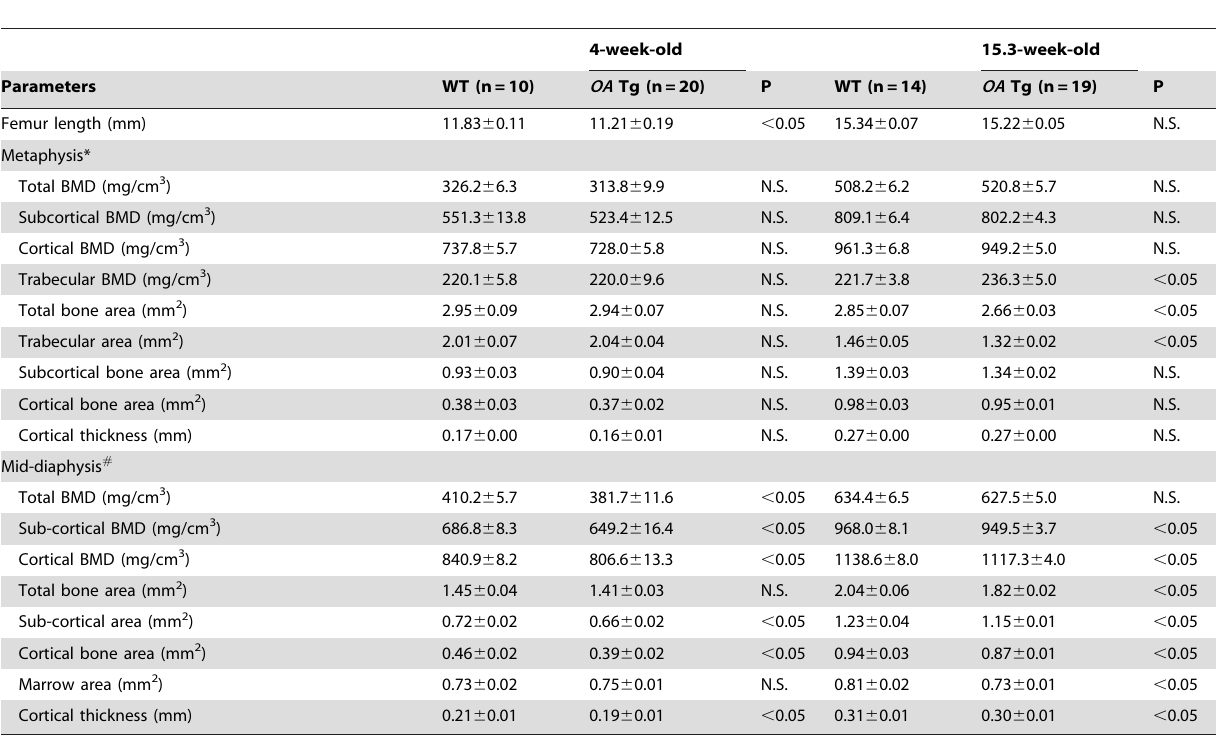
Table 2. Comparison of bone pQCT parameters of weanling young (4-week-old) female OA -Tg mice and mature adult